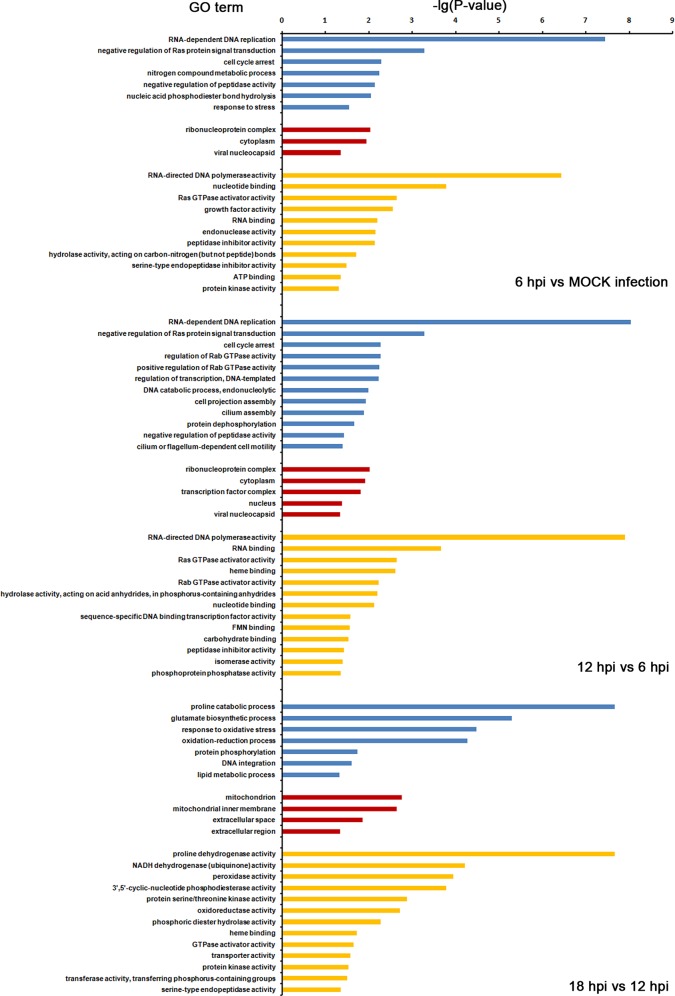
GO analysis of differentially expressed unigenes among different biological processes.GO analysis of differentially expressed SL221 transcripts was performed, and distributions of differentially expressed unigenes at 6 hpi (upper panel), 12 hpi (middle panel) and 18 hpi (lower panel) are shown. Blue represents biological process, Red represents cellular component and yellow represents molecular function.